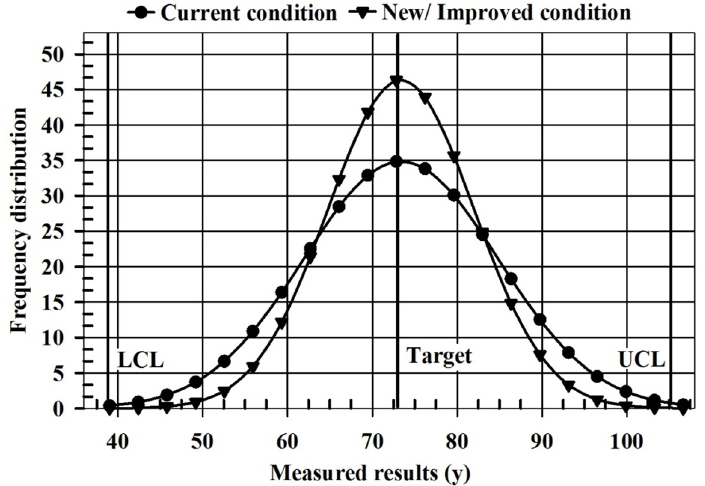
Figure 4. Variation reduction plot showing the performance distribution of sulfate removal under current and improved conditions. (LCL = lower control limit; UCL = upper control